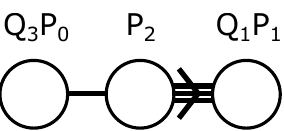
Figure 29. The Kähler parameters of the fibers which form the affine G 2 Dynkin